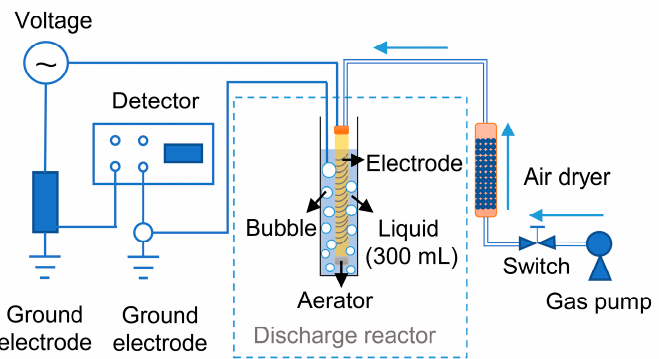
Figure 1. Schematic of the experimental setup of cold plasma device.